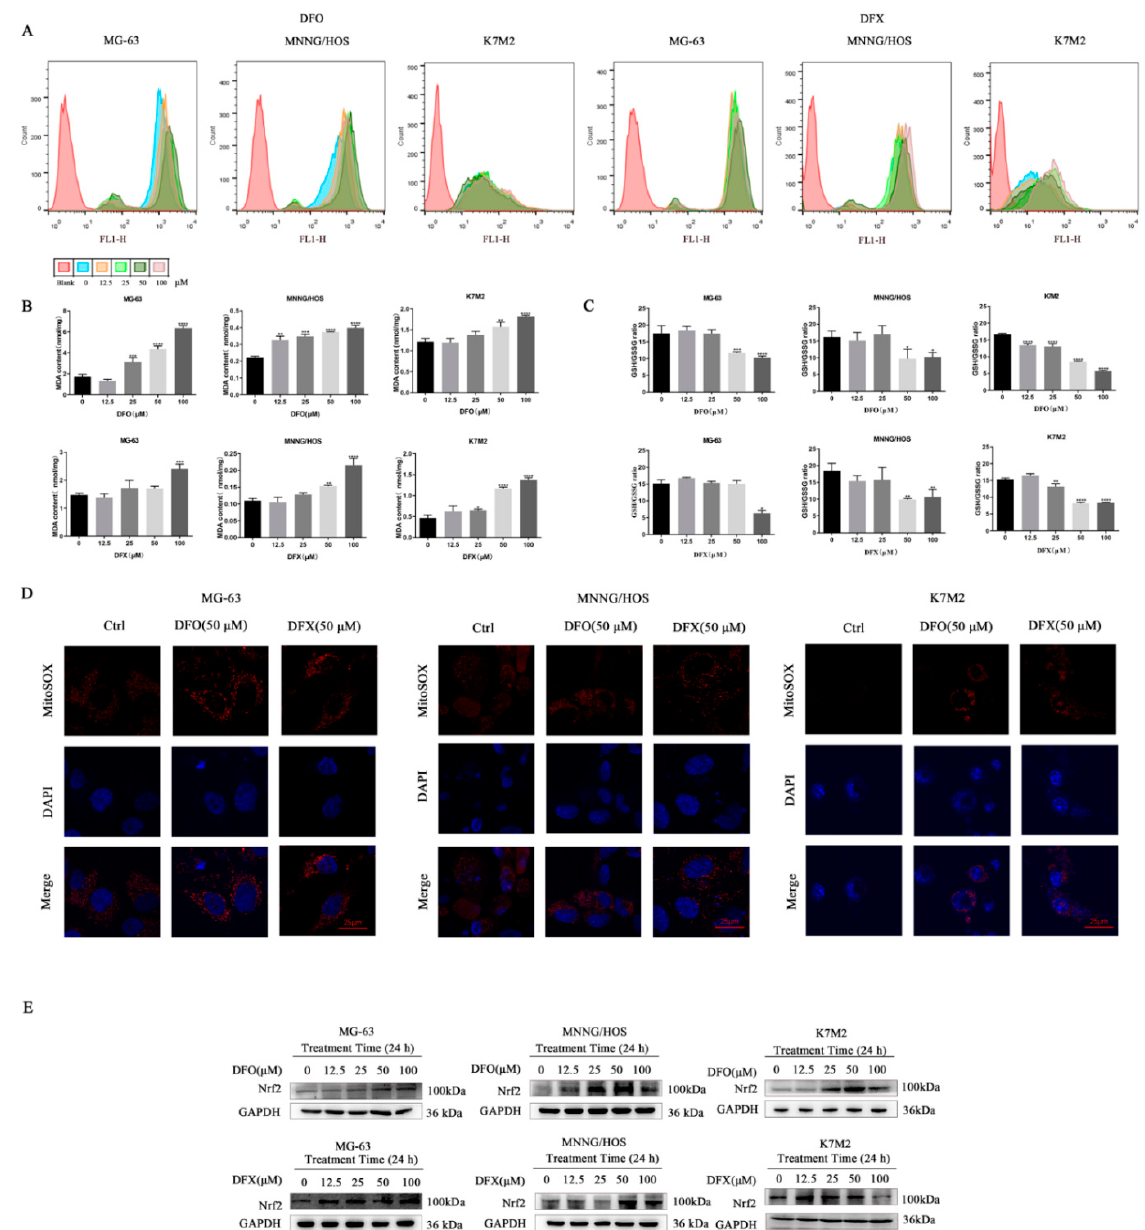
Figure 4. Iron chelators induced oxidative stress in osteosarcoma cells. ( A ) ROS levels in MG-63, MNNG/HOS and K7M2 cells treated with the indicated concentrations of DFO and DFX for 24 h, detected by using a DCFH-DA sensor. ( B ) MDA level in MG-63, MNNG/HOS and K7M2 cells treated with the indicated concentrations of DFO and DFX for 24 h. ( C ) GSH/GSSG ratio in MG-63, MNNG/HOS and K7M2 cells treated with the indicated concentrations of DFO and DFX for 24 h. ( D ) Mitochondrial superoxide production in MG-63, MNNG/HOS and K7M2 cells treated with the indicated concentrations of DFO and DFX for 24 h, observed by a confocal laser scanning microscope. ( E ) Protein expression levels of Nrf2 in MG-63, MNNG/HOS and K7M2 cells treated with the indicated concentrations of DFO and DFX for 24 h. * p < 0.05, ** p < 0.01, *** p < 0.001 and **** p < 0.0001 versus control group.